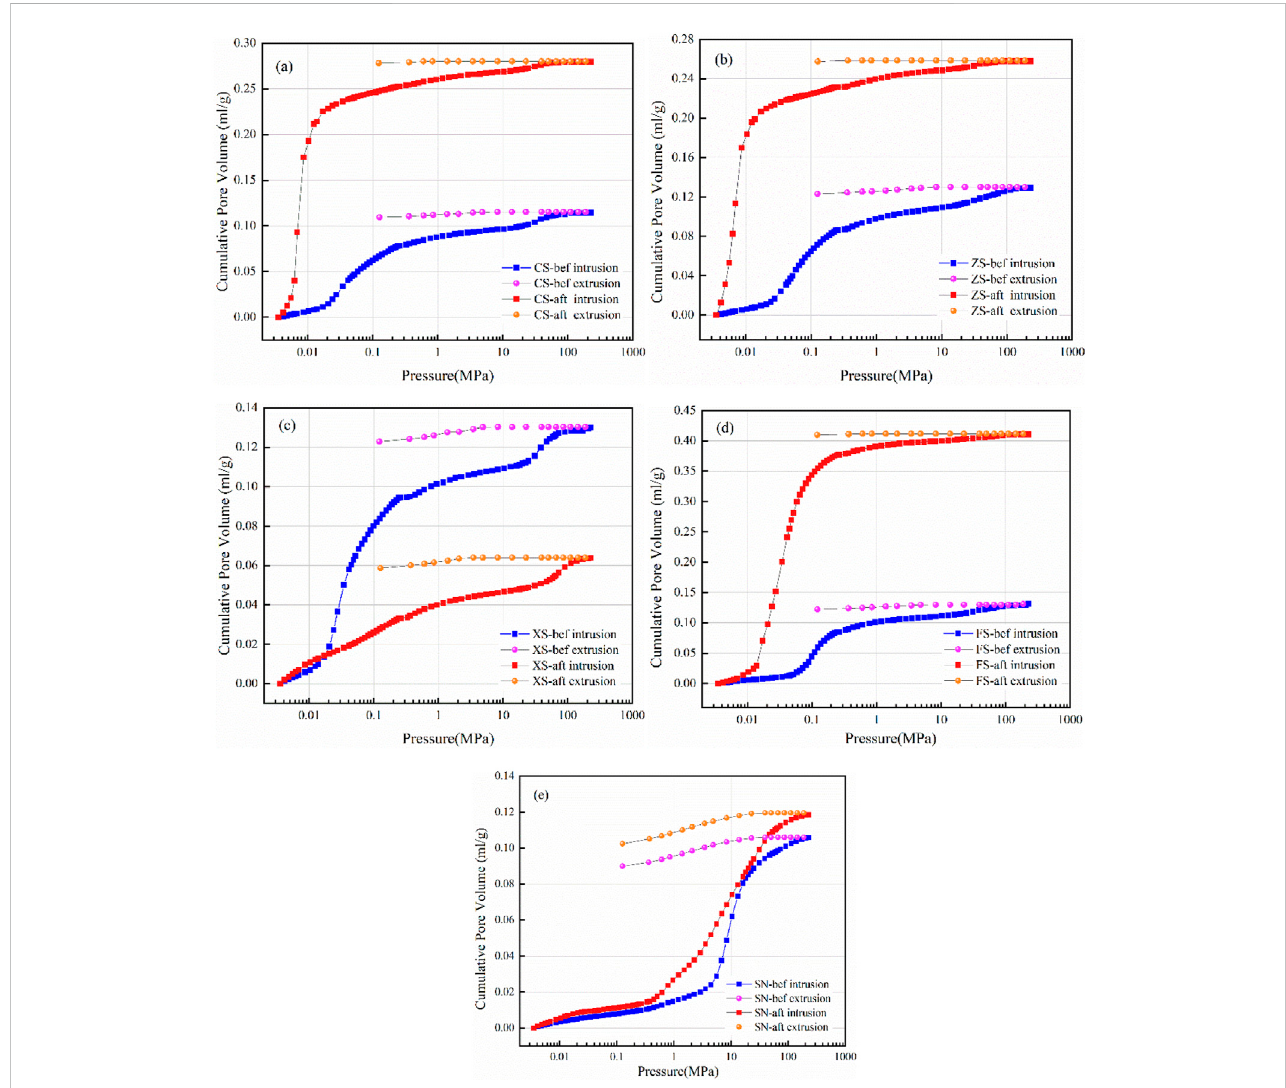
FIGURE 5 Mercury intrusion/extrusion curves of samples: (A – E) represent the samples CS, ZS, XS, FS, and SN.